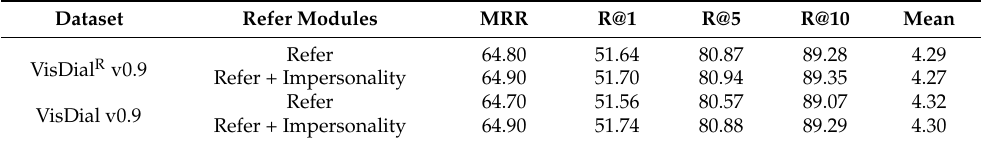
Table 3. Performance comparison between two Refer